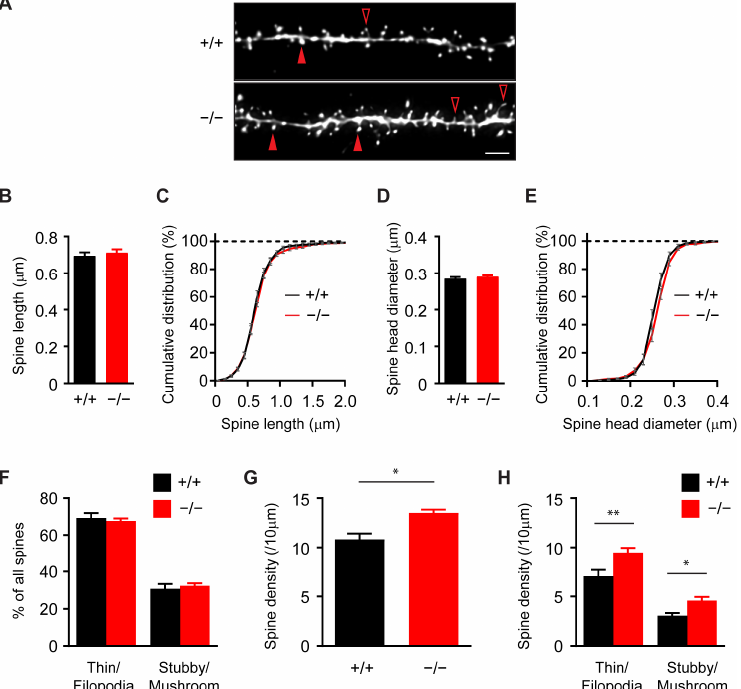
Figure 2. Astroglial Cx43 regulates spine density, but not their properties. ( A ) Representative images of a dendritic segment of a CA1 pyramidal neuron dialyzed with sulforhodamine B via a patch pipette in a wild-type (+/+, top) and a Cx43 − / − ( − / − , bottom) hippocampus. The maximum z-projection of the confocal images containing dendritic spines are shown. ( B – E ) The plots show no significant difference between the averages and cumulative histograms of the spine length ( B , C ), nor in the spine head diameter ( D , E ) between neurons in +/+ and − / − hippocampi ( F ) The relative proportion of the “Thin/Filopodia” or “Stubby/Mushroom” were not different. ( G , H ) Spine density was significantly higher in − / − overall ( G ) and also in both “Thin/Filopodia” and “Stubby/Mushroom” spine categories ( H ). Mean ± SEM; n = 7 +/+ and 6 − / − cells; * p < 0.05, ** p < 0.01; scale bar: 2 µ m in ( A ); and open or filled red arrows denote representative thin/filopodia or stubby/mushroom spines, respectively.